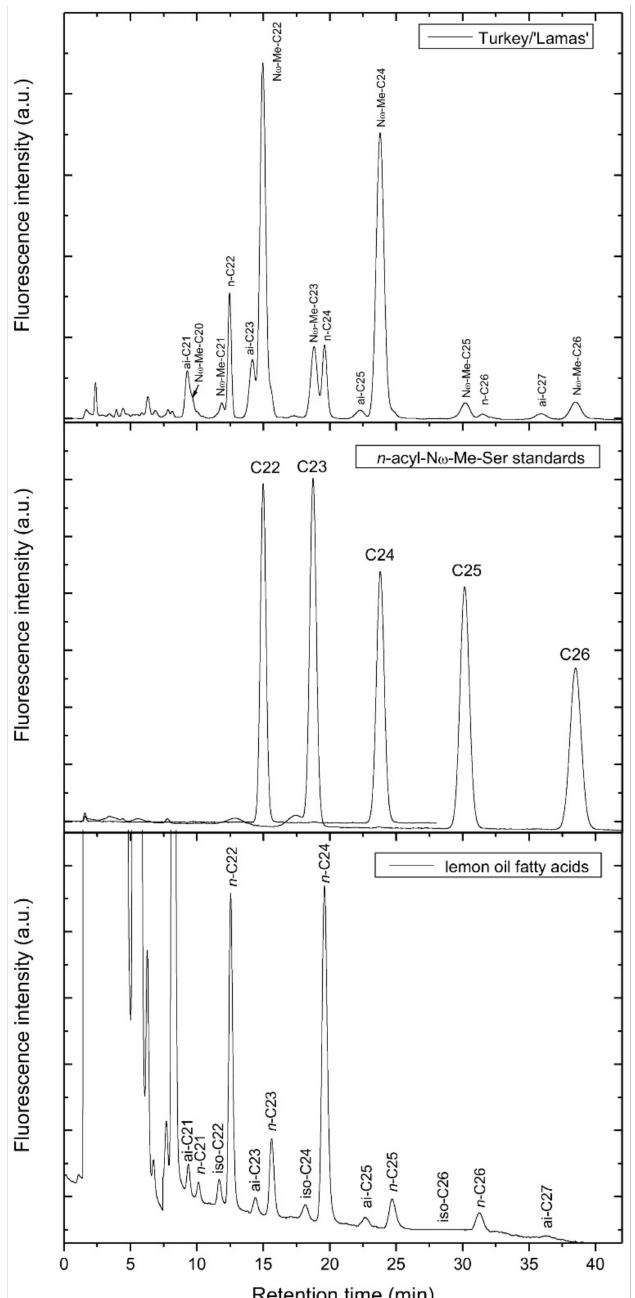
Figure 7. HPLC chromatograms of the extract from inner seed coats of lemon ( top ), n -acyl- N ω - methylserotonin standards ( middle ) and acylserotonins obtained from fatty acids released from lemon seed oil after hydrolysis ( bottom ). Further details are given in the Materials and Meth- ods